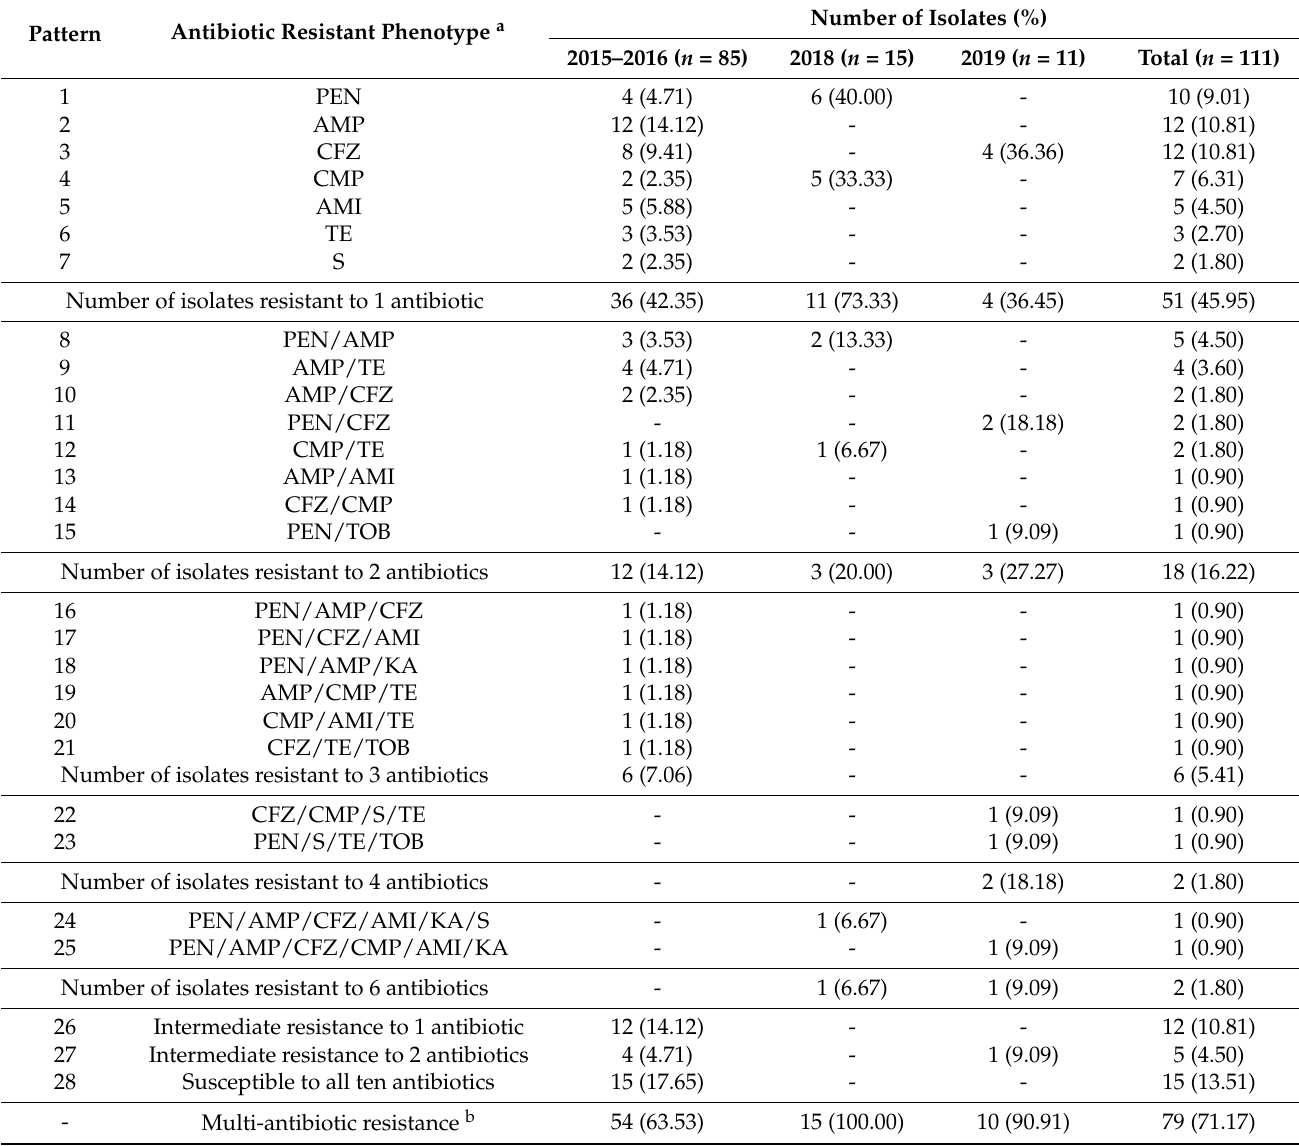
Table 3. Antibiotic-resistant, intermediate, and susceptible patterns of bacteria isolated from juvenile green turtle rearing water at STCCT during the periods January 2015 to April 2016, January to April 2018, and January to April 2019.